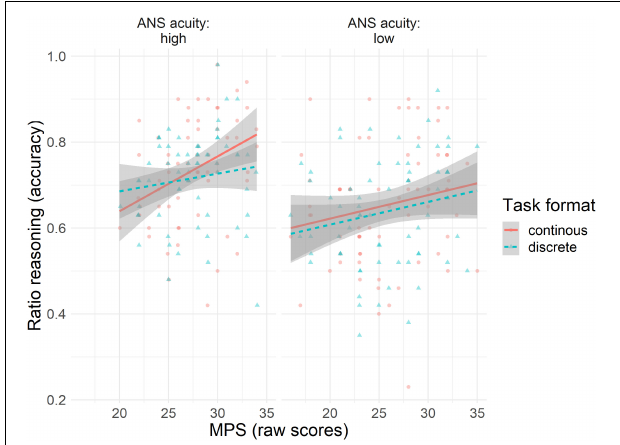
FIGURE 3 | Scatterplots depicting three-way association between ratio reasoning skills ( y -axis) by task format (colored lines), math problem-solving skills ( x -axis), and ANS acuity (paneled: high and low correspond to above and below the sample mean,